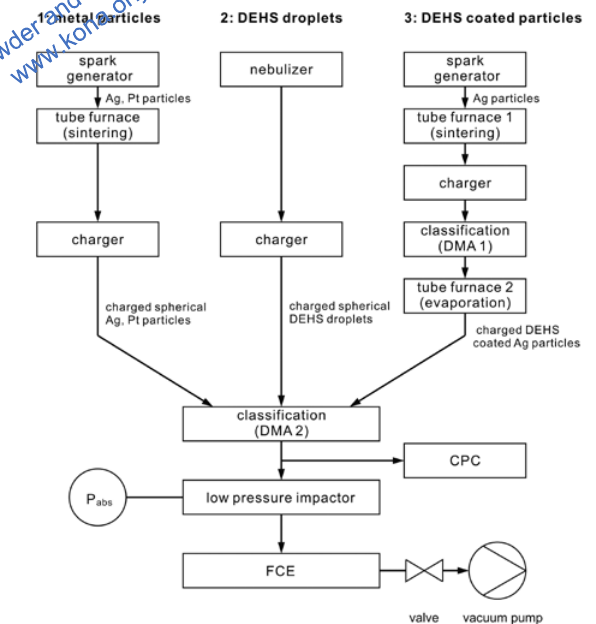
Fig. 1 Overview of the experimental set-up to investigate the separation behaviour of different particle types.